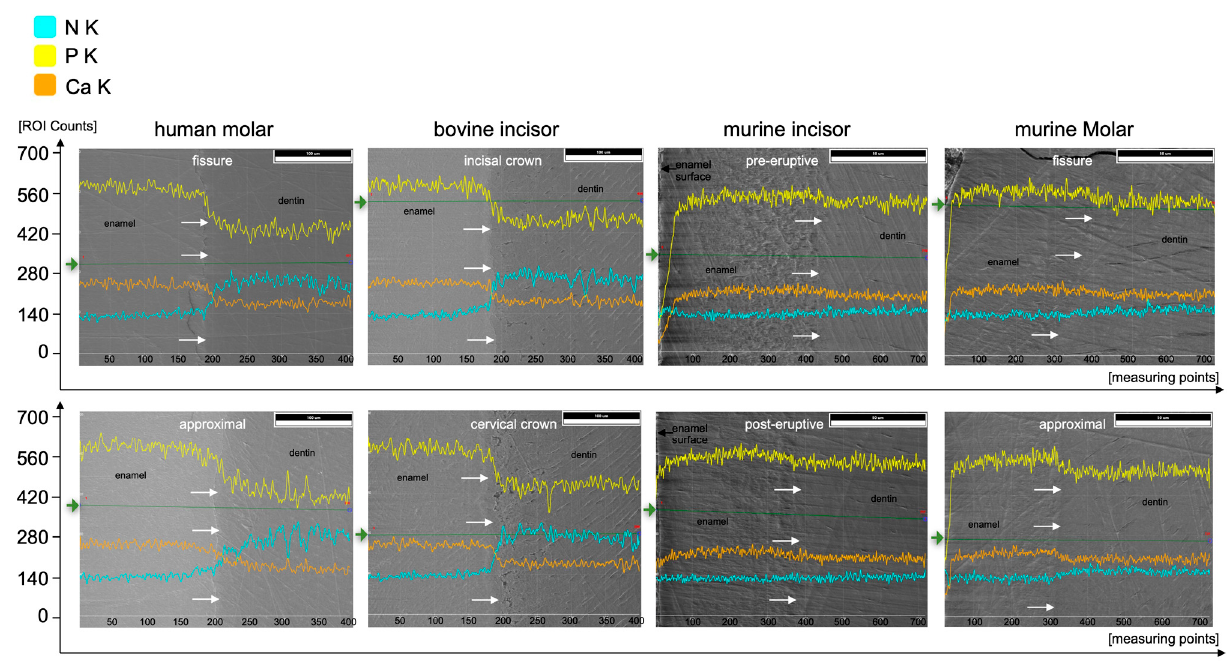
Figure 7. EDX line scans crossing the enamel-dentin junction (white arrows, enamel on the left, dentin on the right parts) of the respective species and areas along the green lines (starting from green arrows) for elements N (cyan), P (yellow), and Ca (orange).